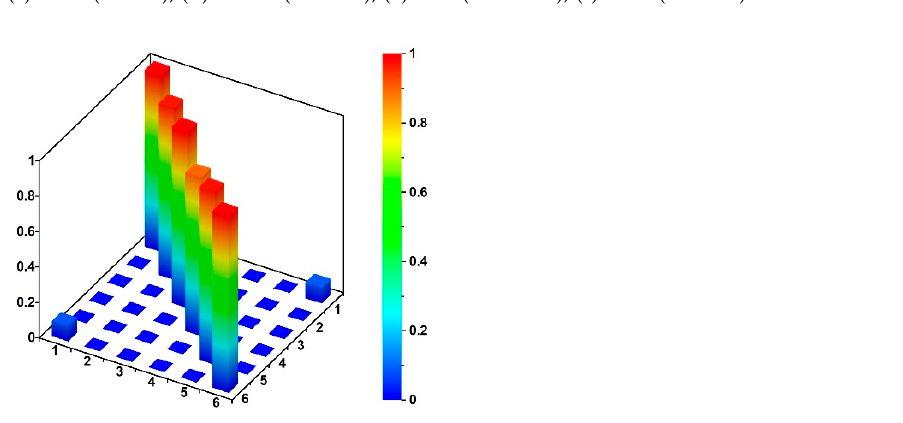
Figure 18. The six basic mode shapes of the footbridge: ( a ) first (vertical), ( b ) second (torsional, ( c ) third (lateral), ( d ) fourth (vertical), ( e ) fifth (torsional), ( f ) sixth (vertical).